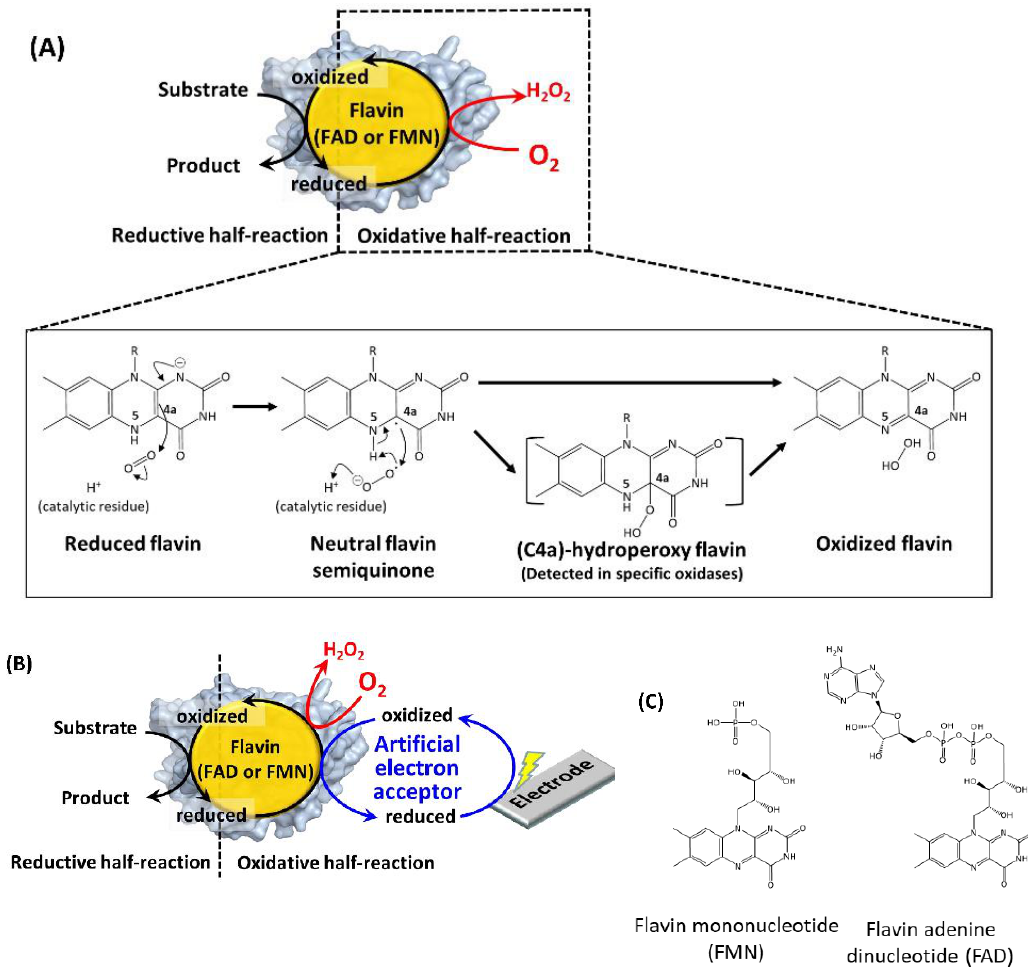
Figure 1. ( A ) Reaction scheme of a flavin-dependent oxidase with molecular oxygen [20]. ( B ) Reaction scheme of a flavin-dependent oxidase or dehydrogenase with an artificial electron acceptor. Oxidases react with oxygen, as shown by the red arrow and character. Both oxidases and dehydrogenases react with artificial electron acceptors as electron mediators between enzymes and electrodes. ( C ) Flavin mononucleotide (FMN) and flavin adenine dinucleotide (FAD) structural formulas.